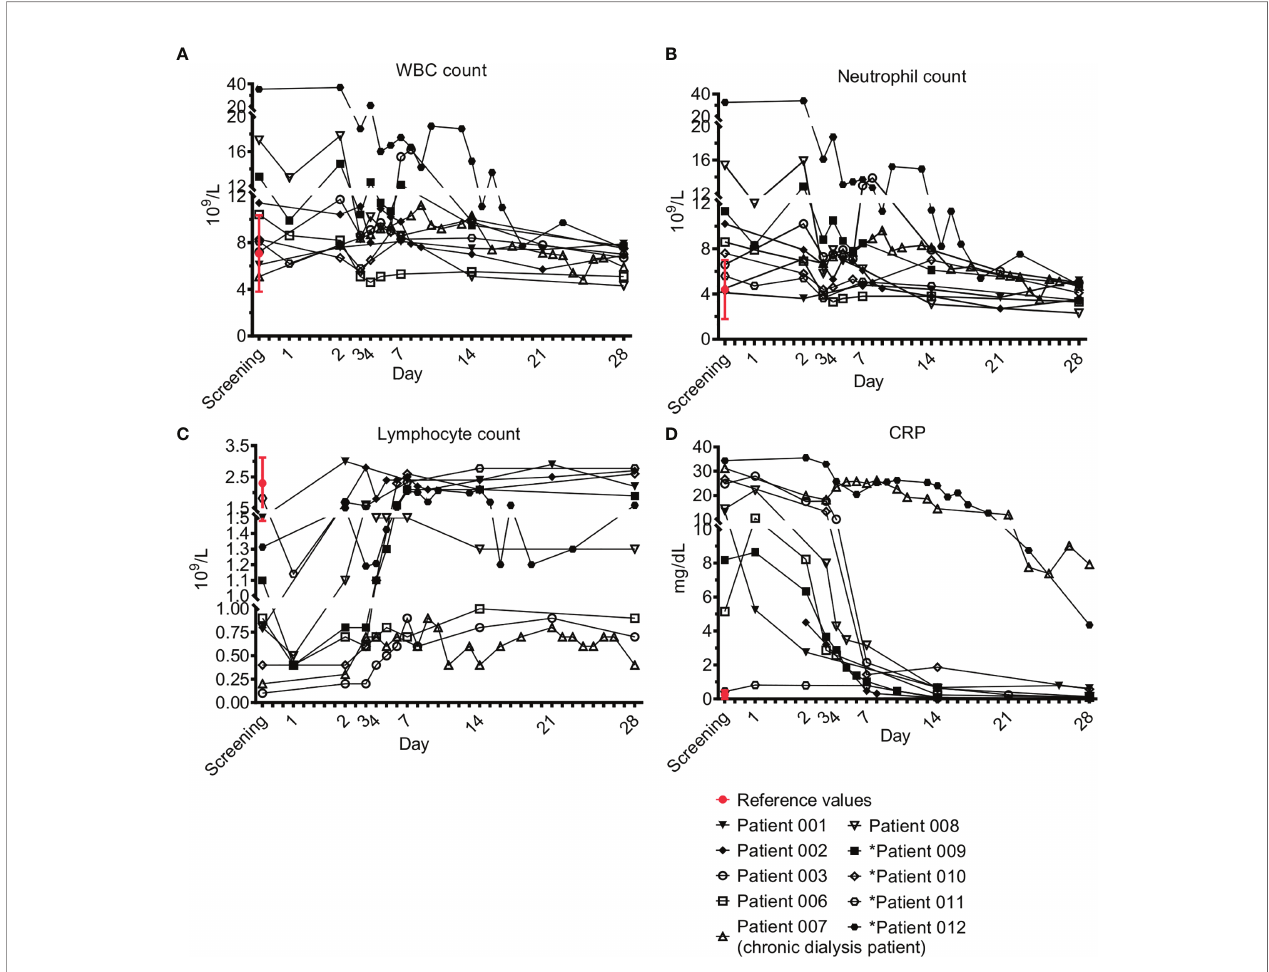
FIGURE 1 | Acute phase markers. Complete blood count (CBC) and C-reactive protein (CRP). Blood counts of fresh peripheral patient blood ethylenediamine tetraacetic acid (EDTA) samples were performed using blood analyzer. The differential of white blood cells (WBC), i.e. WBC subpopulations, was calculated. ‘ Screening ’ is a time point with a blood count that was performed 24 ± 6h before treatment with Allocetra-OTS, to test for the patient ’ s eligibility for Allocetra-OTS treatment. ‘ Day 1 ’ is a blood sample just prior to Allocetra-OTS infusion. Numbers (10 9 cells/L) of (A) WBCs, (B) neutrophils, and (C) lymphocytes, are shown. (D) CRP levels of all patients in the indicated time points. * Patients 09 – 12 received two doses of Allocetra-OTS (days 1 and